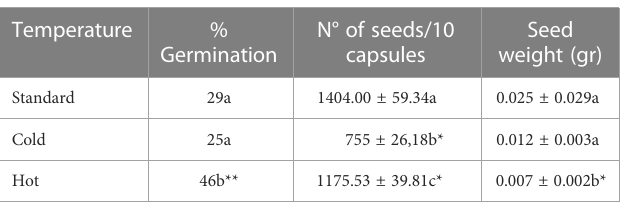
TABLE 2 Effect of temperature on seed germination and size.